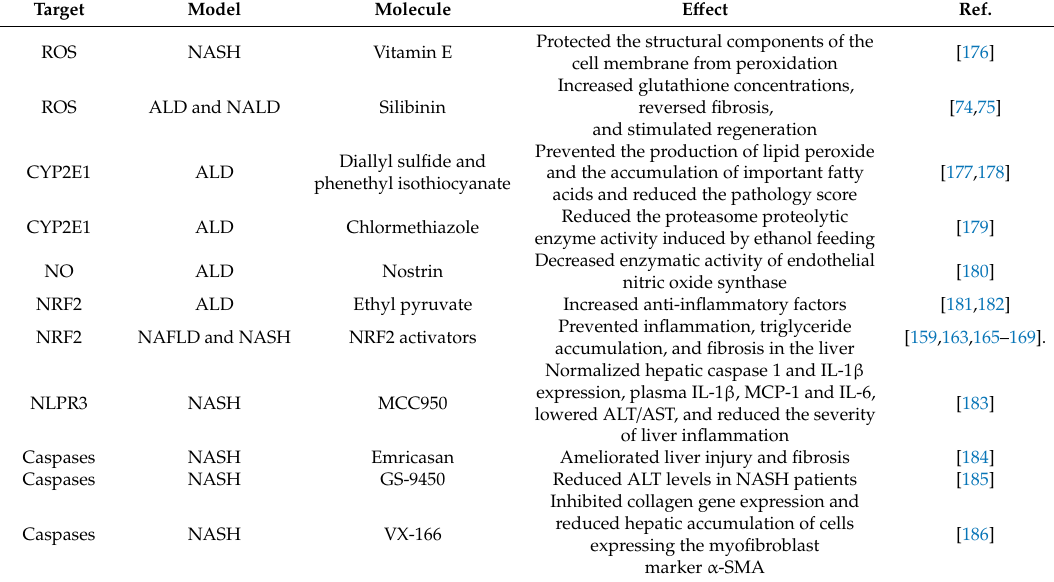
Table 2. Possible molecular targets to develop antifibrotic